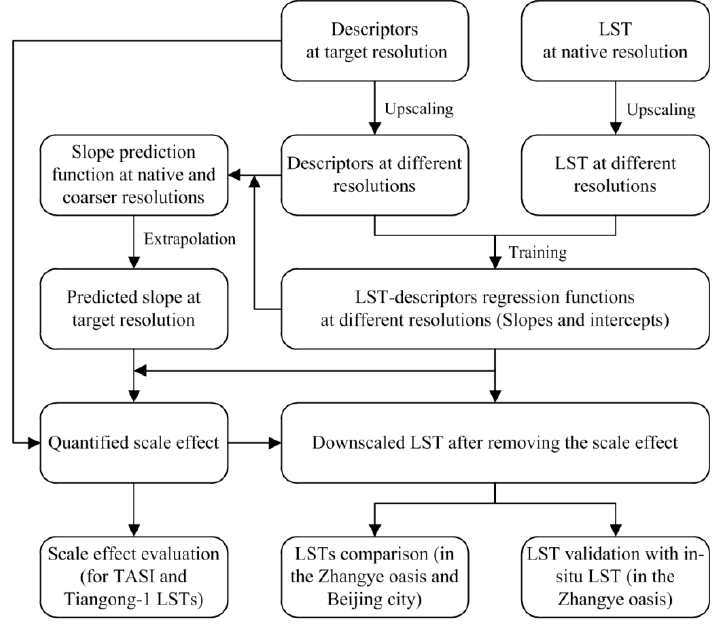
Figure 2. Flowchart of this study.